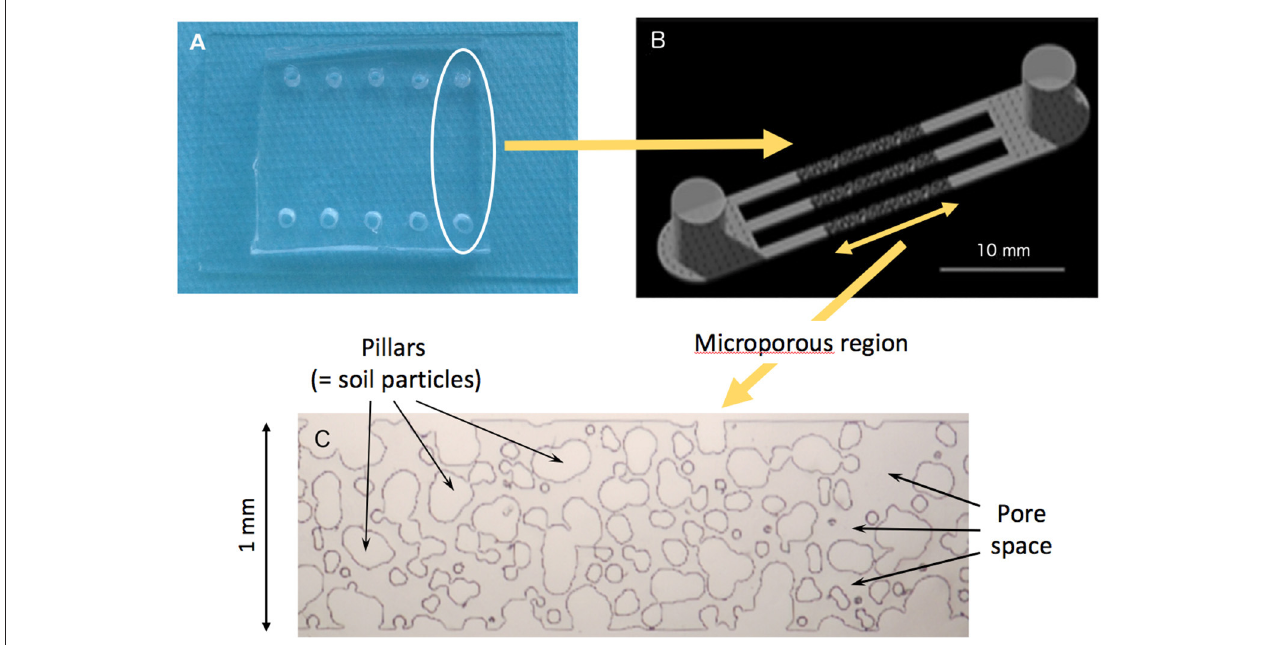
FIGURE 1 | (A) Picture of the experimental system showing the rows of inlet and outlet wells. (B) Each channel has a micro-structured region 10mm long, 1mm wide, and 34 ± 3 µ m-deep, sandwiched between 5 mm-long open channels. Access ports are 1cm high and 4mm in diameter. (C) Micrograph of the 2-D pore structure, with pores (darker color) located between simulated soil particles (lighter